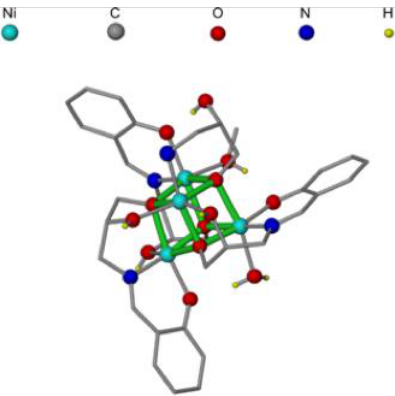
Figure 1. Structure of 1 taken from the Cambridge Crystallographic Data Centre (CCDC). Solvate molecules, anion and all H atoms bonded to C omitted for clarity. Central {Ni 4 O 4 } cubane unit bonds highlighted in green.